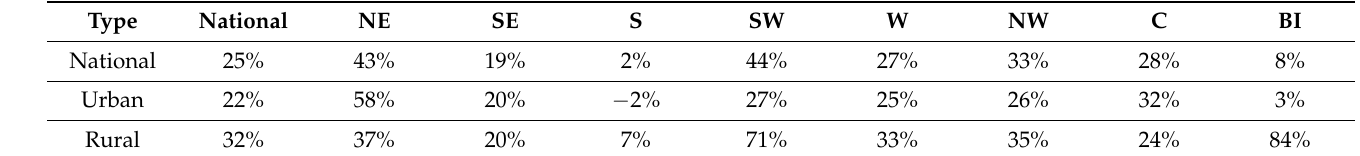
Table 3. Mortality reduction over decades—national, regional, and urban–rural.